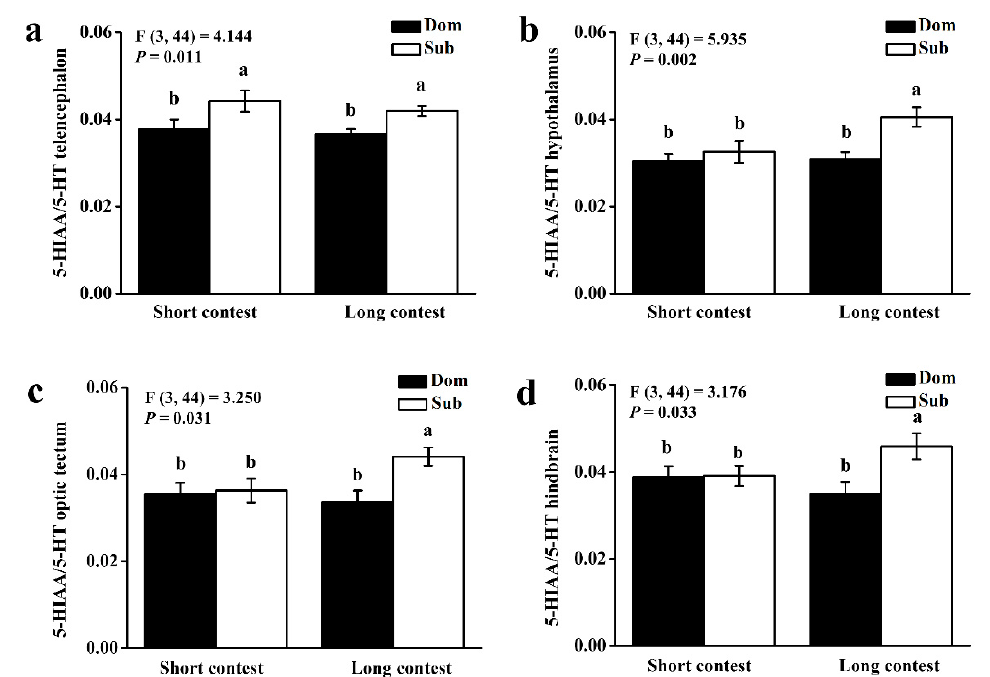
Figure 2. 5-hydroxyindoleacetic acid (5-HIAA) / 5-hydroxytryptamine (5-HT) ratios of ( a ) telencephalon, ( b ) hypothalamus, ( c ) optic tectum, and ( d ) hindbrain in dominant (Dom) and subordinate (Sub) black rockfish from short-term contest to long-term contest. Di ff erent letters indicate significant di ff erences among these four groups, which were detected by one-way ANOVA ( p < 0.05). Values are mean ± S.E. ( n = 12).